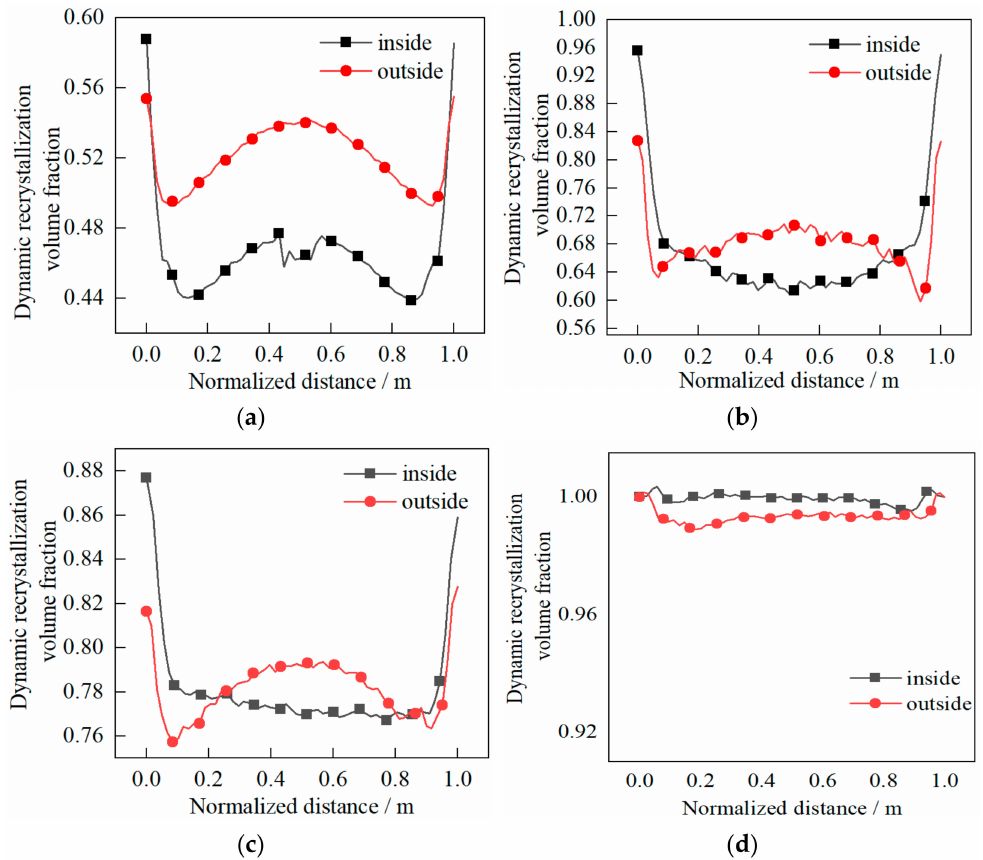
Figure 14. Evolution characteristics of recrystallization volume fraction in two passes of rolling: ( a ) first pass rolling, without shear effect; ( b ) first pass rolling, with shear effect; ( c ) second pass rolling, without shear effect; ( d ) second pass rolling, with shear